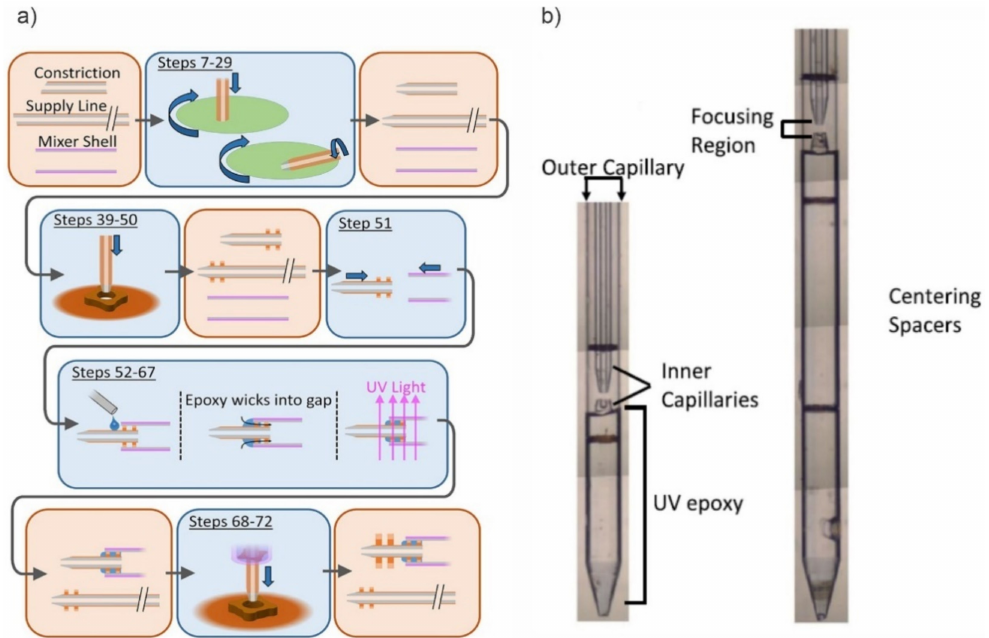
Figure 2. Glass capillary-based GDVN devices. ( a ) overview of the multi-step device fabrication process (reprinted with permission from Reference [28]). ( b ) Optical composite images of the completed devices (reproduced with permission from Reference [27] and Reference